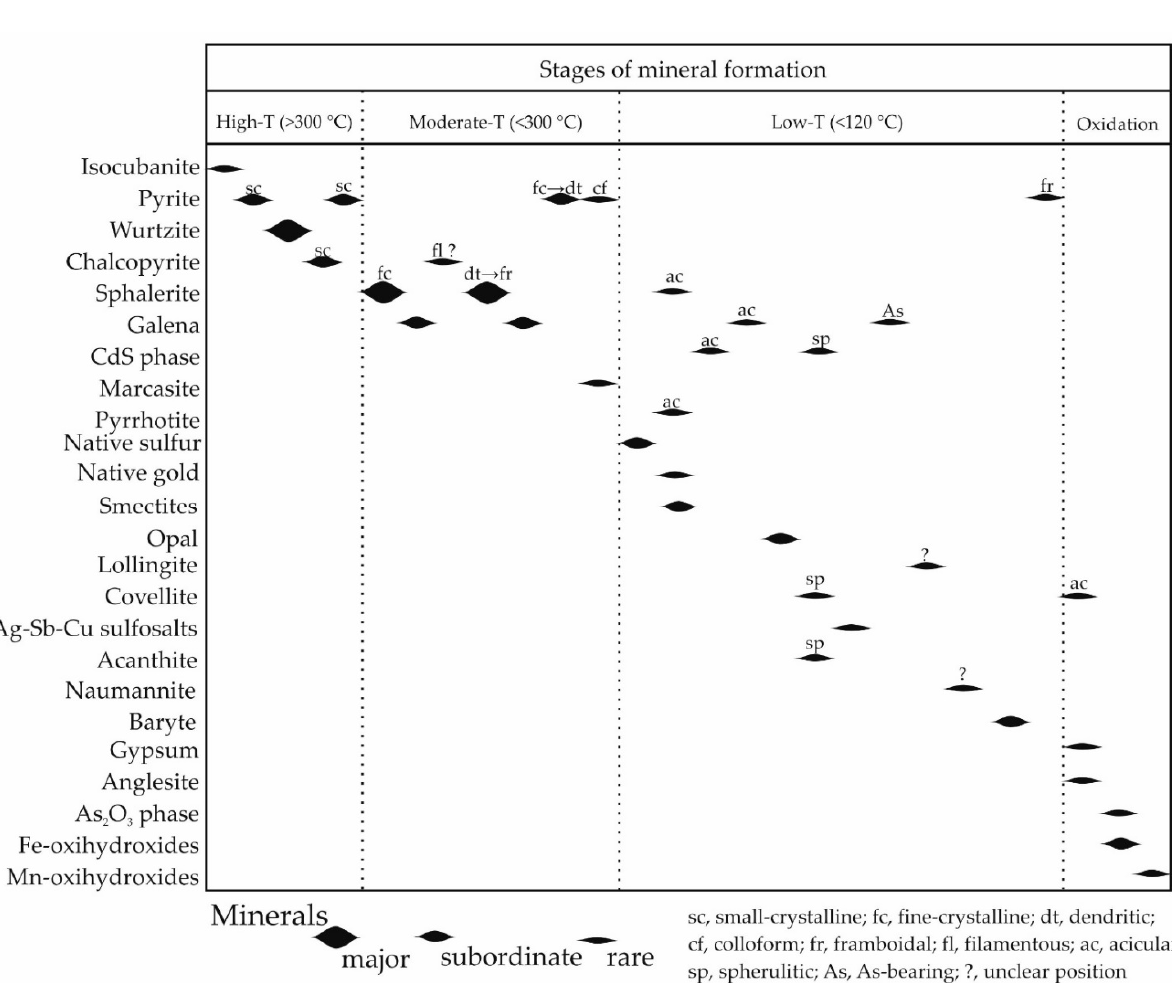
Figure 12. A paragenetuc sequence of mineral formation in Zn-rich smoker chimneys of the Iri- novskoe HSF.